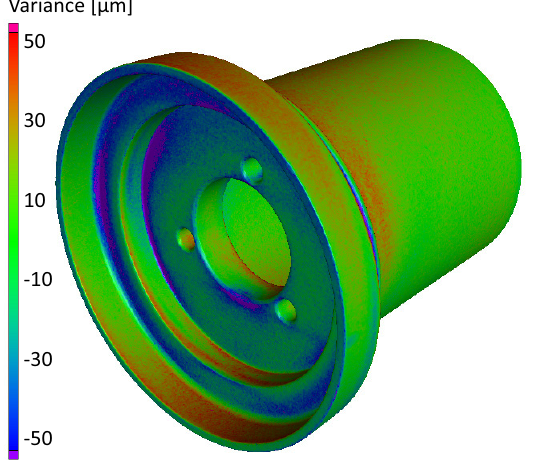
Fig. 6. Colour map of the pipe connector showing deviations between a volume model and a surface model